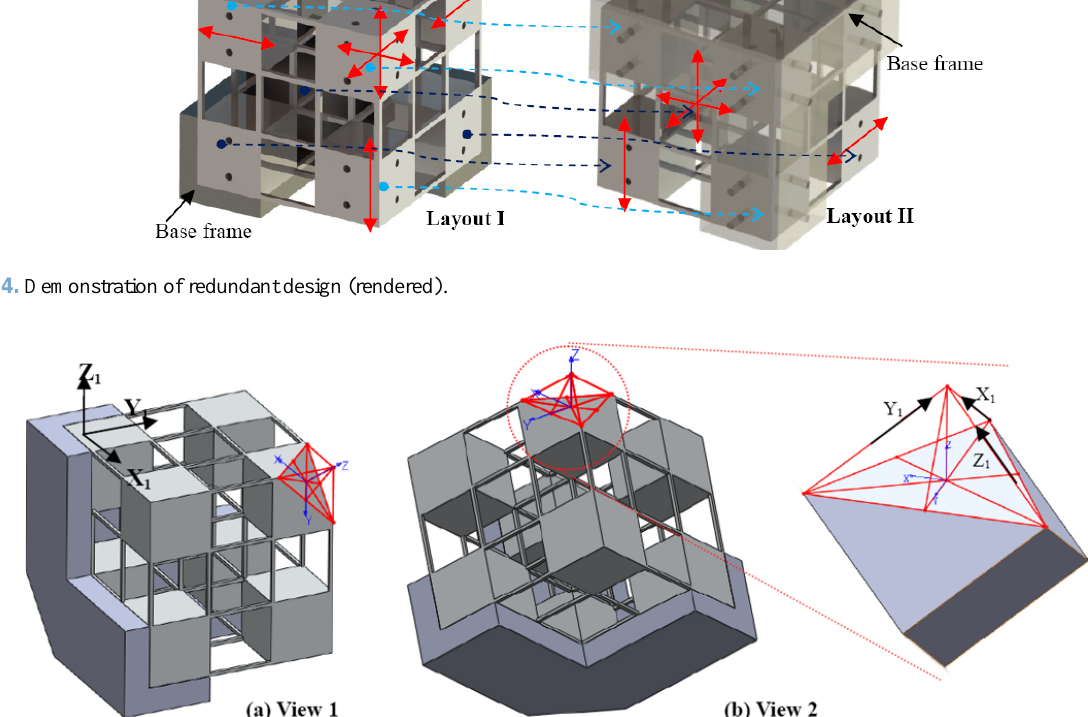
Figure 5. A variation for the monolithic decoupled XYZ